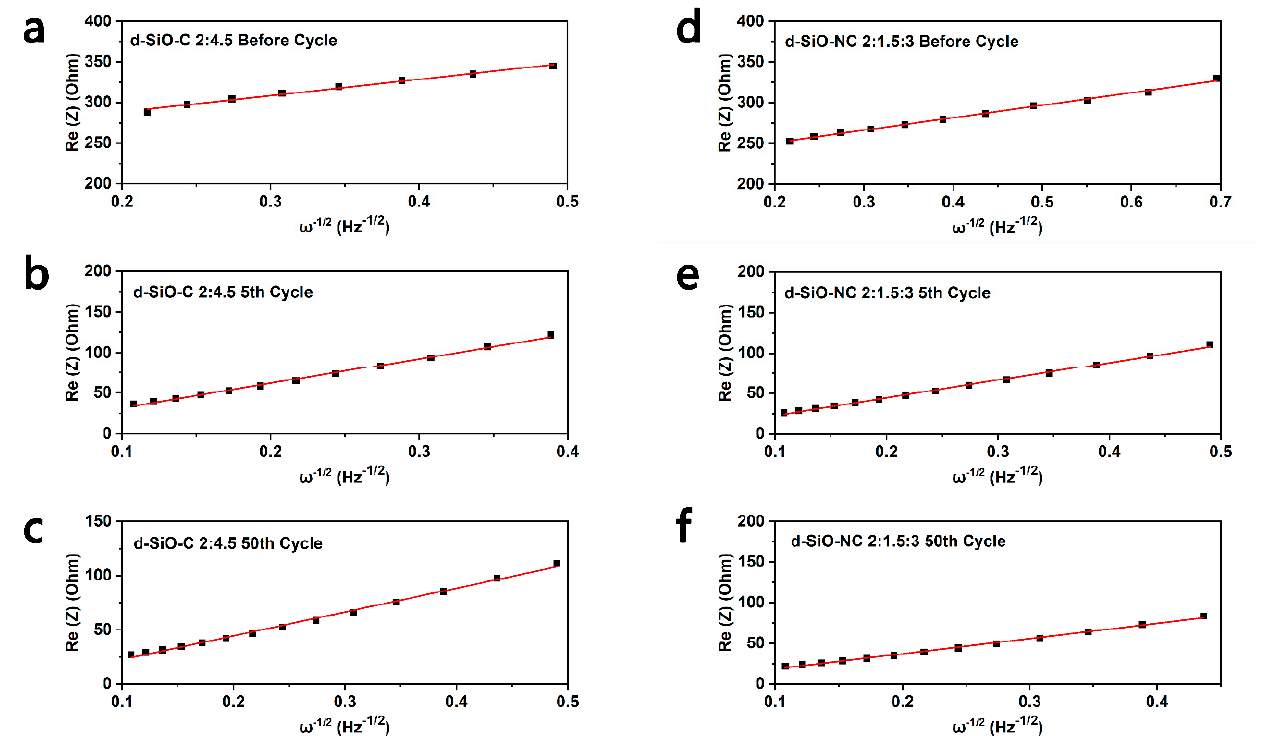
Figure 8. The relationship between Re(Z) and square root of inverse angular frequency, ω − 1/2 in low frequency region for d-SiO-C//Li cell ( a ) before cycle, ( b ) after 5th cycle and ( c ) after 50th cycle, and d-SiO-NC//Li cell ( d ) before cycle, ( e ) after 5th cycle and ( f ) after 50th cycle. Table 3. Warburg coefficient and lithium ion chemical diffusion coefficient calculated by EIS methods.